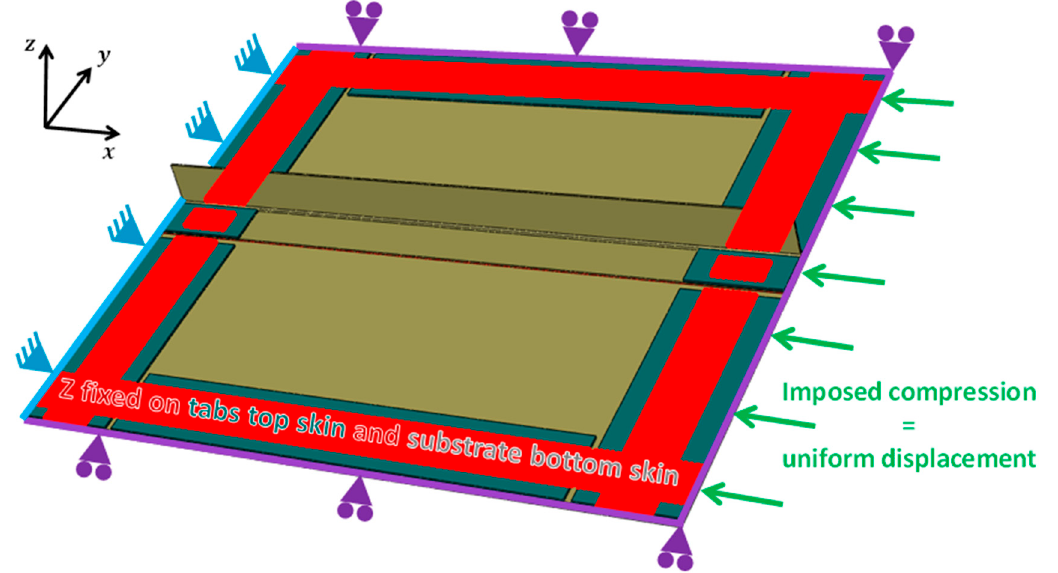
Figure 8. Boundary conditions imposed to represent compression of the sample along the 𝑥 direc- tion.